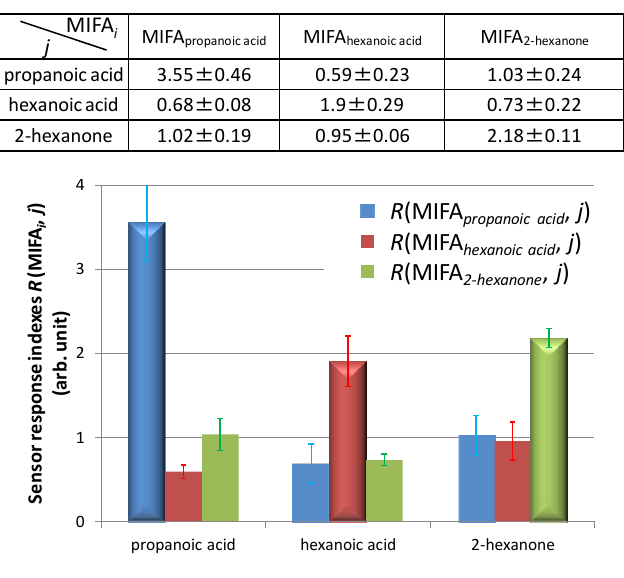
, j ) to i , j ). 3D effect bars were used to 0 , i i